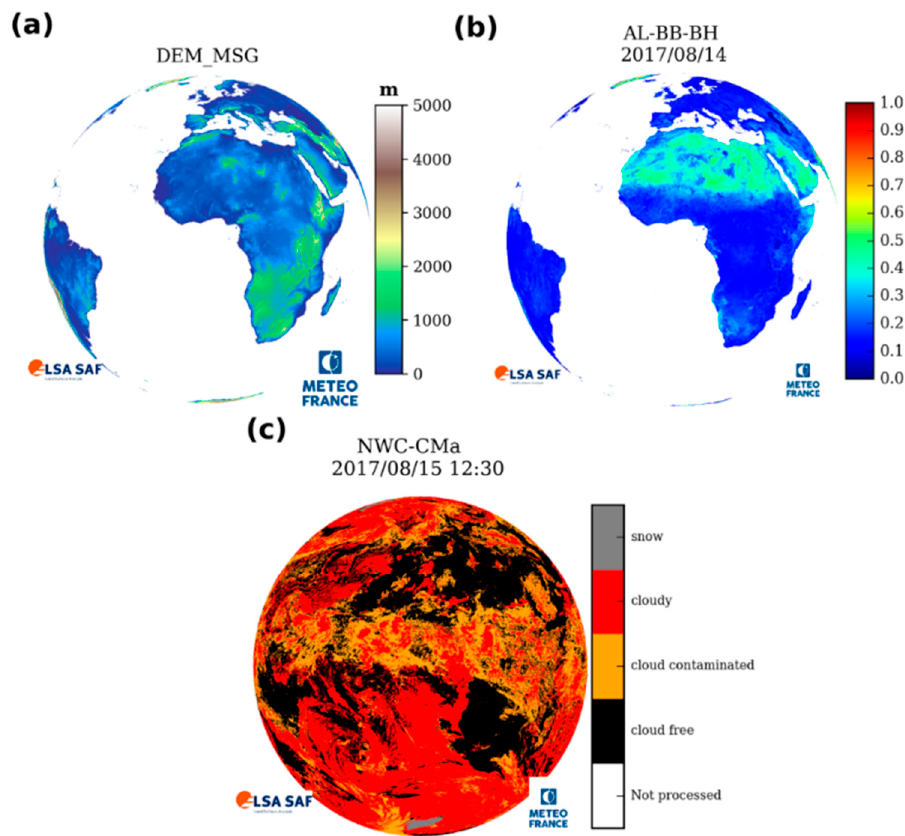
Figure 3. Examples of auxiliary input data used for the estimation of DSSF for the 15 August, 2017 at 12:30UTC: ( a ) MSG Digital Elevation Model (called DEM MSG ), ( b ) LSA SAF MSG Daily Land Surface Albedo (MDAL) product for the 14 August 2017 (day before the processing), ( c ) NWC SAF cloud mask at the exact date and time of the DSSF estimation.